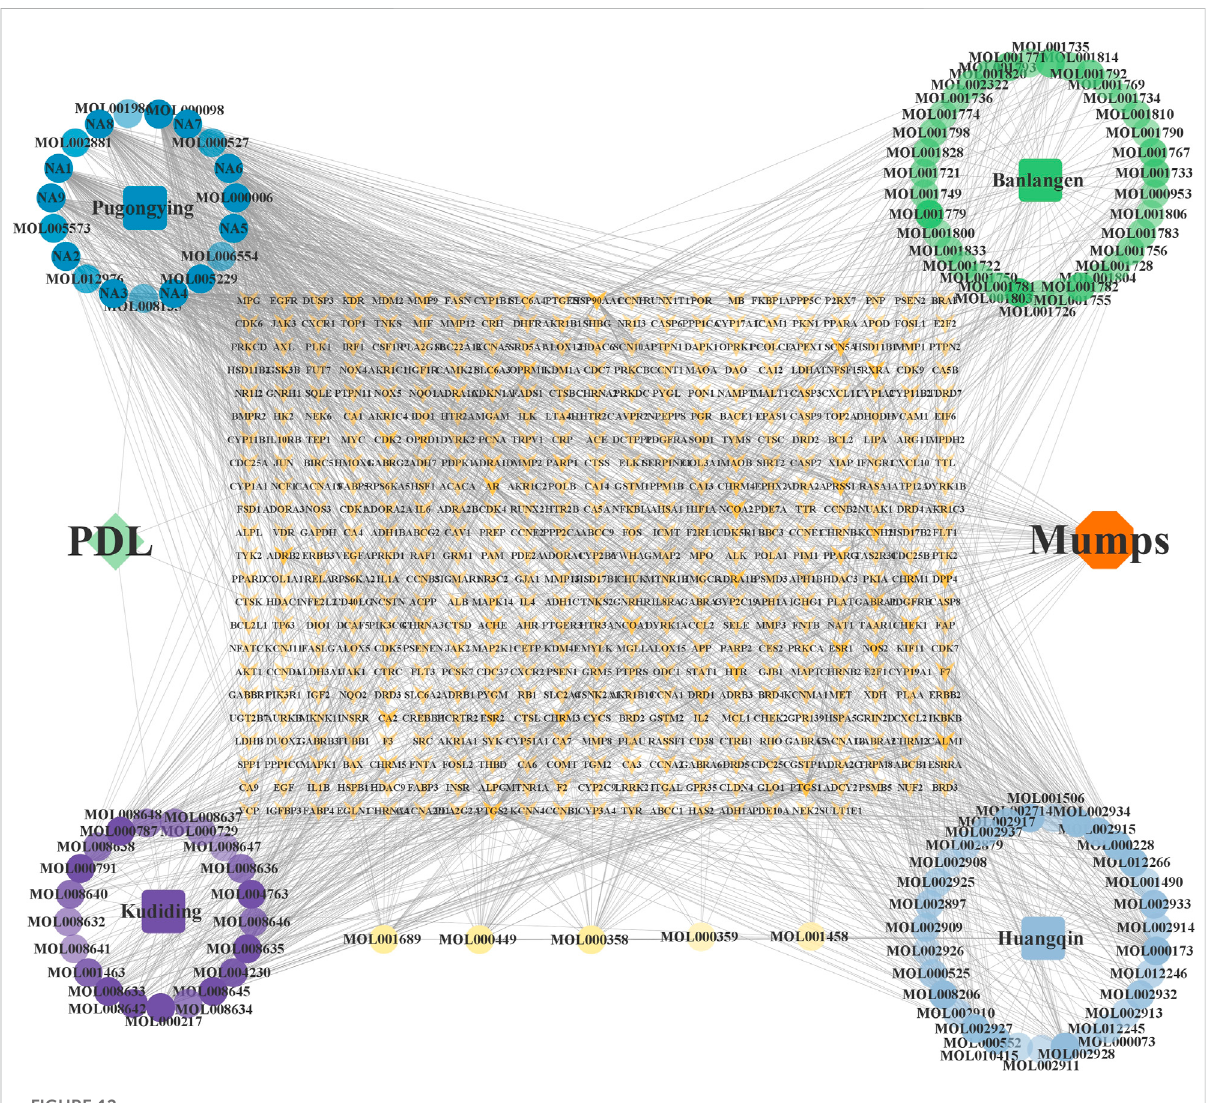
FIGURE 12 Drug-component-target